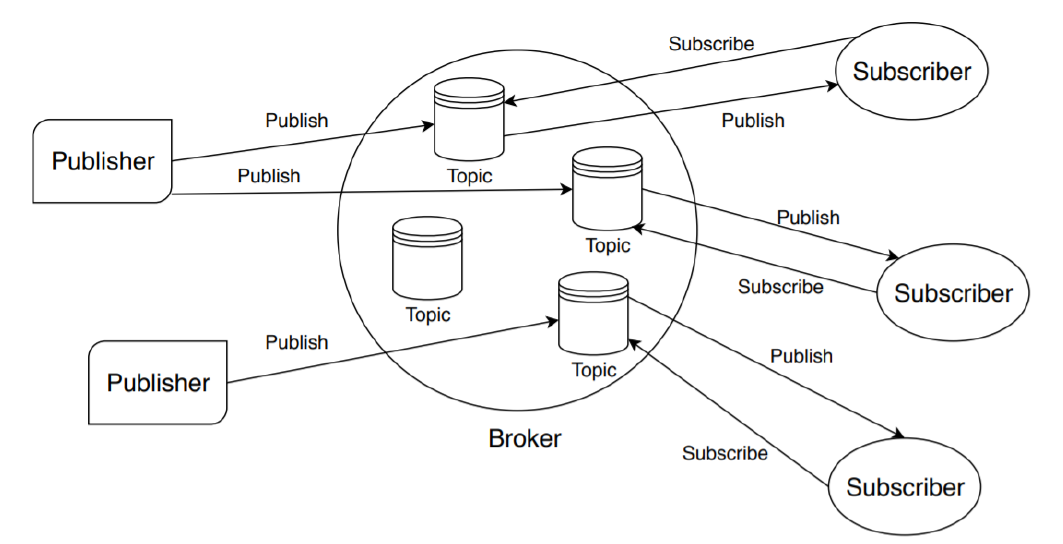
Figure 1. The main entities of the MQTT